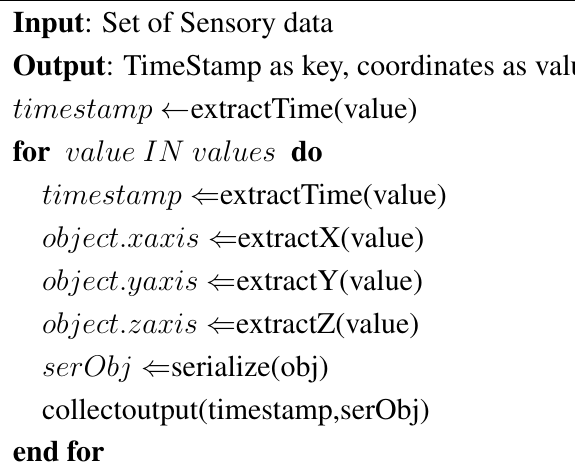
Algorithm 3 Map Algorithm for frequency of